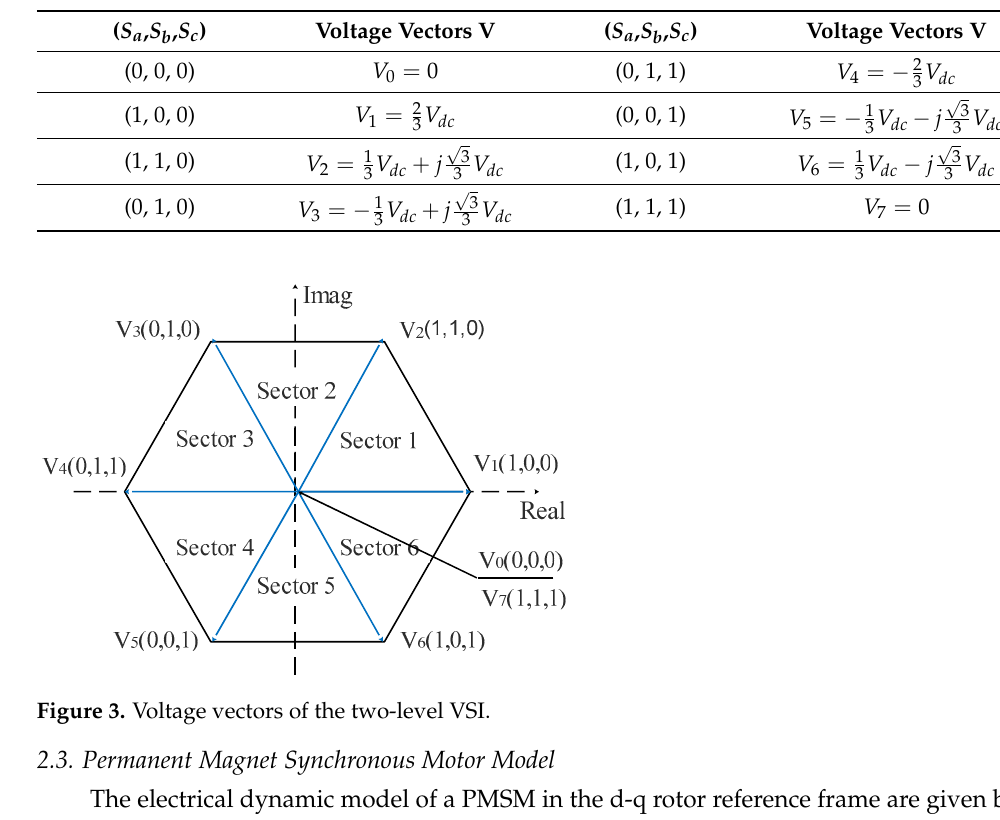
Table 2. Switching states and voltage vectors of the VSI.